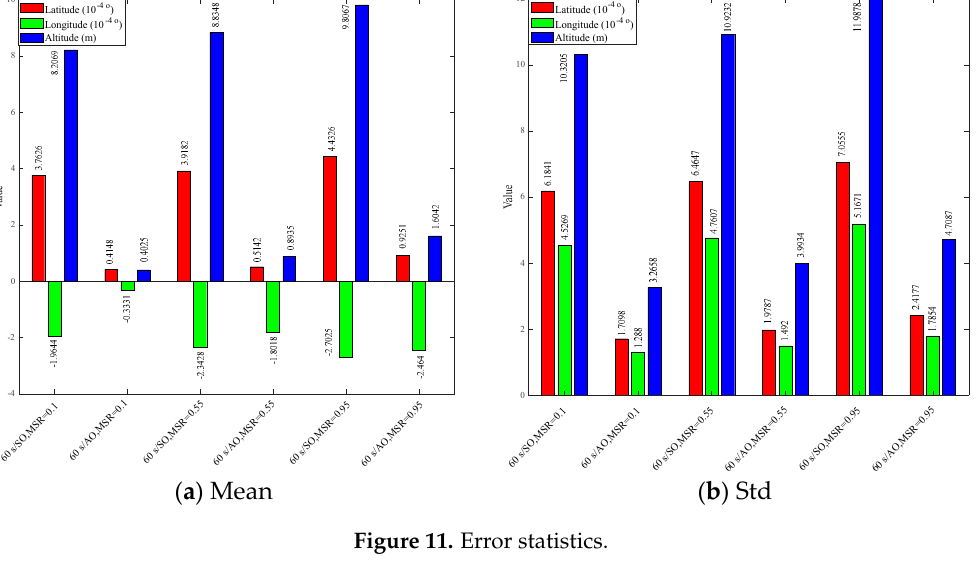
Figure 11. Error statistics.